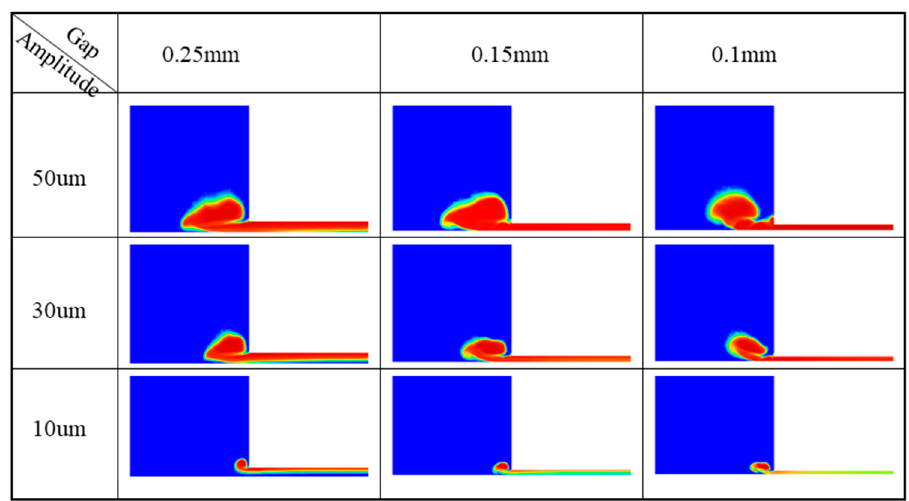
Figure 5. Variation in the vapor fraction with respect to the amplitude and gap (time = 300 μ s).